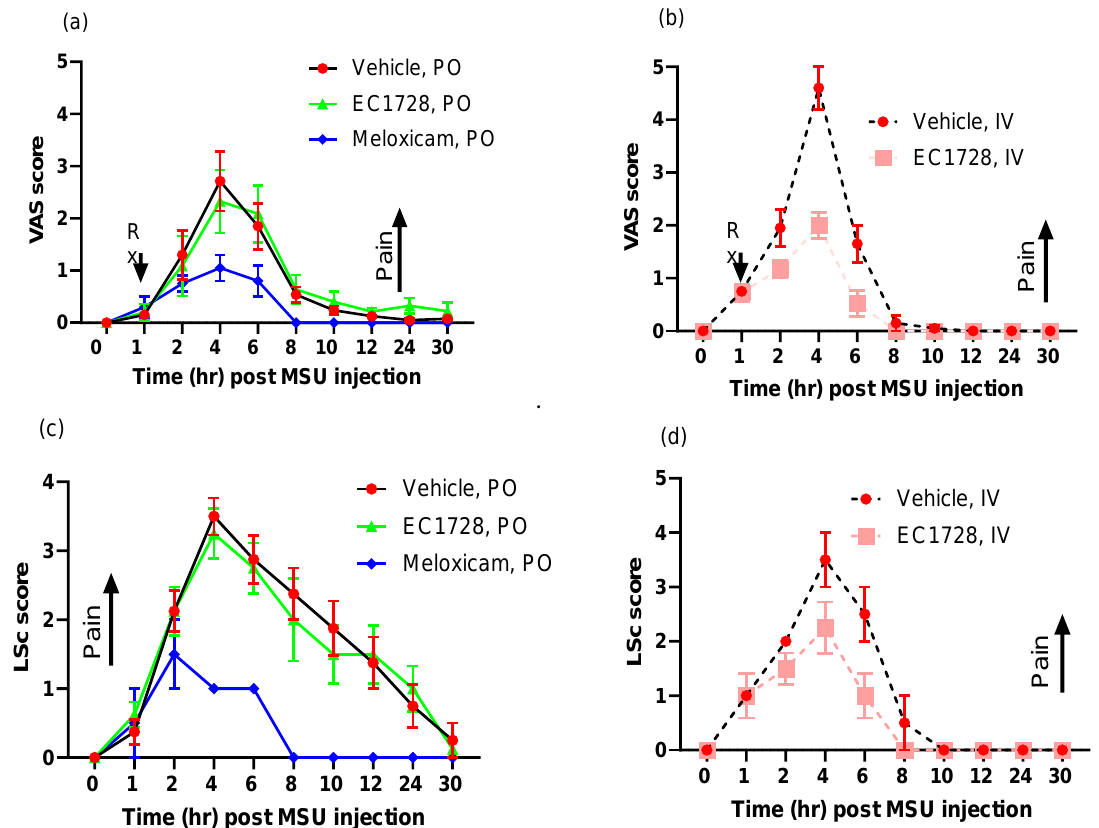
Figure 4. Analgesic activity of EC1728 and meloxicam in cats after MSU injection (mean ± SEM). EC1728 was administered once orally at 3 mg/kg or IV at 0.1 mg/kg 60 min after MSU injection. Meloxicam served as a positive control and was administered once orally at 0.1 mg/kg 60 min after MSU injection. Pain response was recorded by ( a , b ) visual analog scale (VAS) or ( c , d ) lameness score (LSc). A vehicle control matched each dosing regimen (IV, PO). Oral administration of EC1728 did not alter the pain response after MSU injection, but a single IV dose significantly decreased pain in both recorded pain measures ( p < 0.05). n = 8 for vehicle and EC1728, IV, and n = 4 cats were used for EC1728, PO. An n = 2 cats were used for IV vehicle and meloxicam since the response was consistent with previous results (not shown) this was deemed sufficient for comparison.